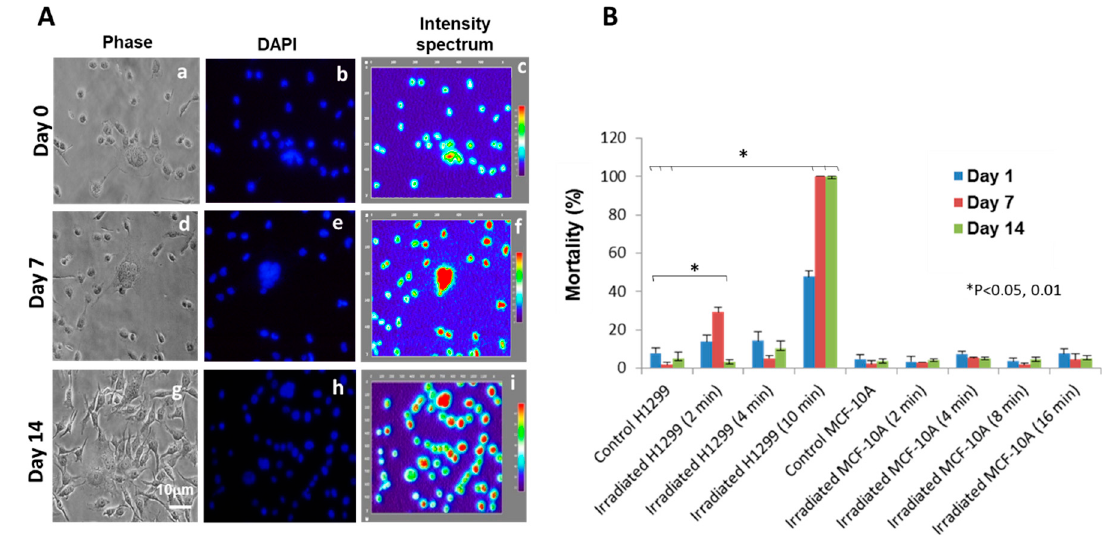
Figure 4. ( A ) Mortality effect following 4 min of W-band (75–105 GHz) MMW treatment on H1299 cell line. Scale bars correspond to 10 μ m. ( B ) The number of cells counted for each group was 400–550. Each experiment was repeated four times. * indicates p -value < 0.01.